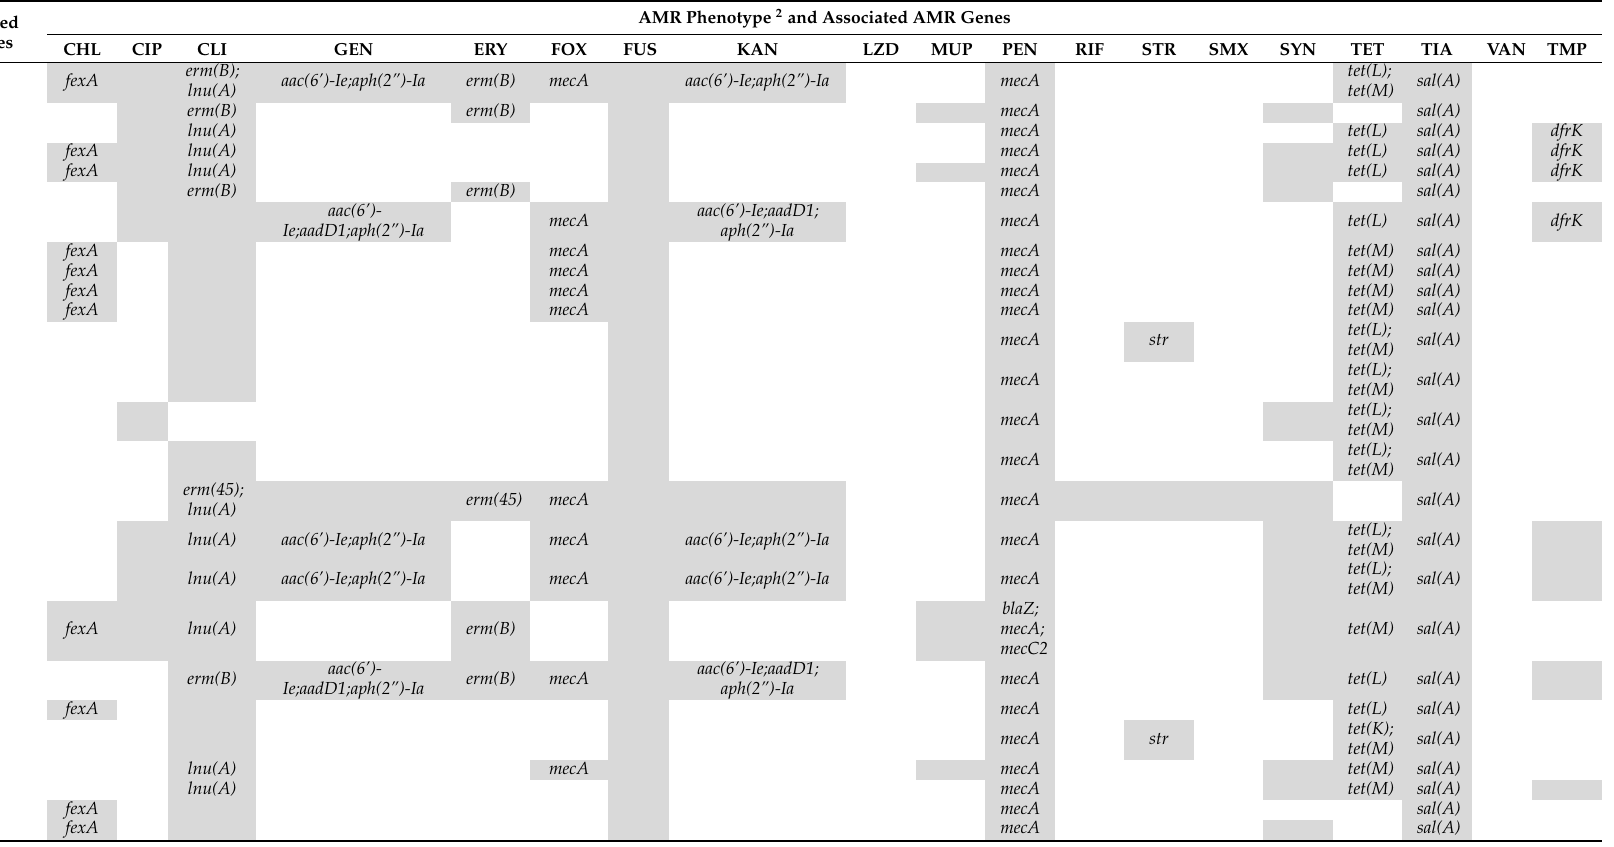
Table 1. Predicted antimicrobial resistance genes compared to phenotype according to minimum inhibitory concentrations of various antimicrobial substances for the M. sciuri isolates. Non-wildtype phenotypes were evaluated according to EUCAST ECOFFs. Grey background represents resistance to respective antimicrobial